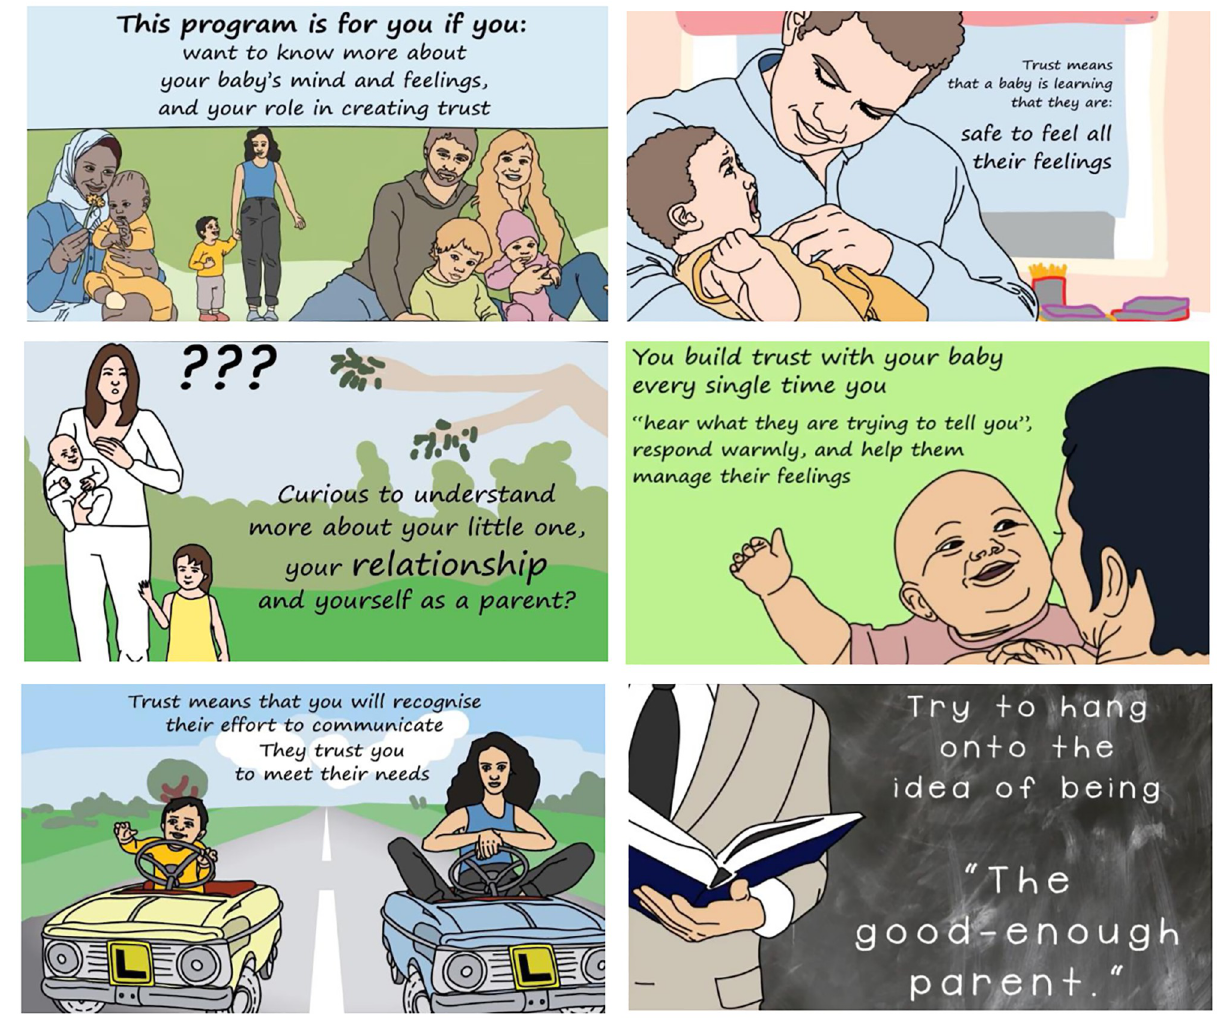
Fig 2. Screenshots from MERTIL for Parents video